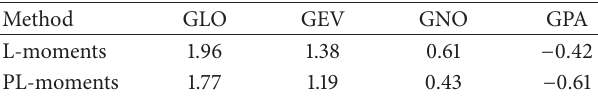
Table 5: 𝑍 -test result for the goodness of fit.